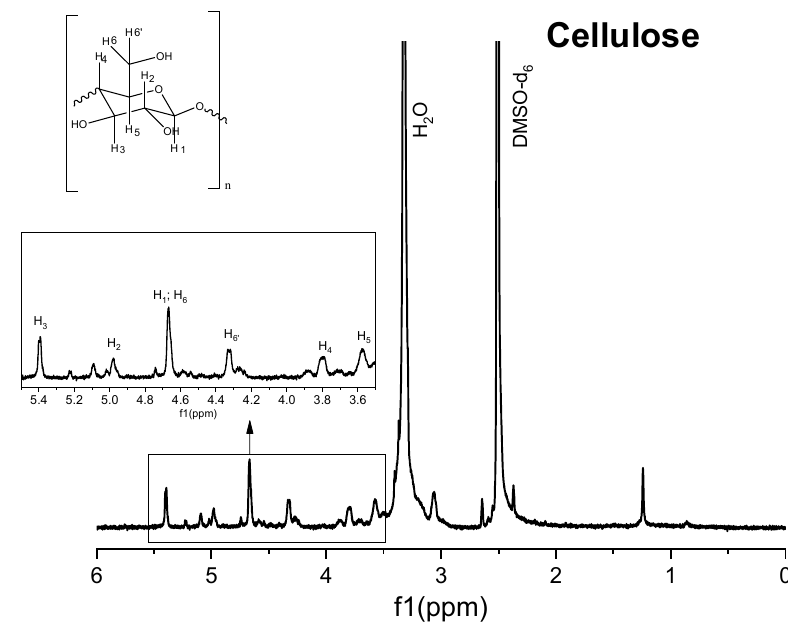
Appl. Sci. 2019 , 9 , x FOR PEER REVIEW Figure 6. 1 H nuclear magnetic resonance (NMR) spectrum of commercial cellulose.